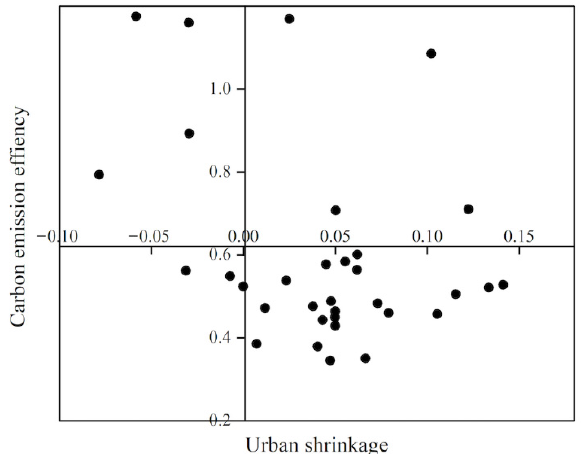
Figure 5. Analysis of urban shrinkage and carbon emission efficiency characteristics.